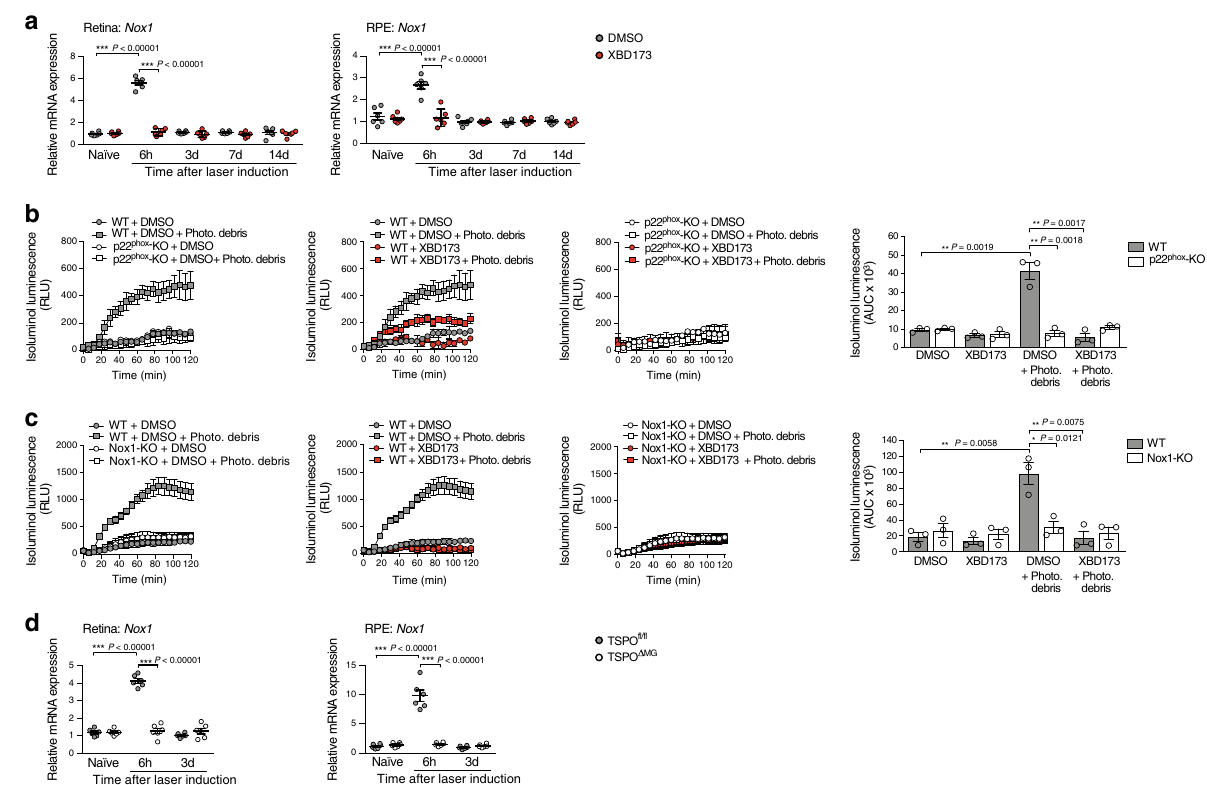
Fig. 5 ROS production by primary microglia involves TSPO-dependent NOX1 activation. a Laser-induced gene expression of Nox1 in retina and RPE/ choroid of DMSO-treated or XBD173-treated mice. Transcript levels for each enzyme were normalized to β -Actin. n = 6 retinas/RPEs from individual mice. b and c Quanti fi cation of extracellular ROS production by primary microglia from WT and p22 phox -KO mice b , Nox1-KO mice c . Kinetics of ROS production and the area under the curve (AUC) are shown. Where indicated, primary microglia were stimulated with photoreceptor cell debris. n = 3 independent experiments. d Laser-induced gene expression of Nox 1 in retina and RPE/choroid of TSPO fl / fl and TSPO Δ MG mice. Transcript levels for each enzyme was normalized to β -Actin. n = 6 retinas/RPEs from individual mice. Data shown as mean ± SEM. ROS data were analyzed using two-tailed unpaired Student ’ s t test. A linear mixed model was used for laser-CNV data; * P < 0.05; ** P < 0.01; and *** P ≤ 0.001. Source data are provided as a Source Data fi